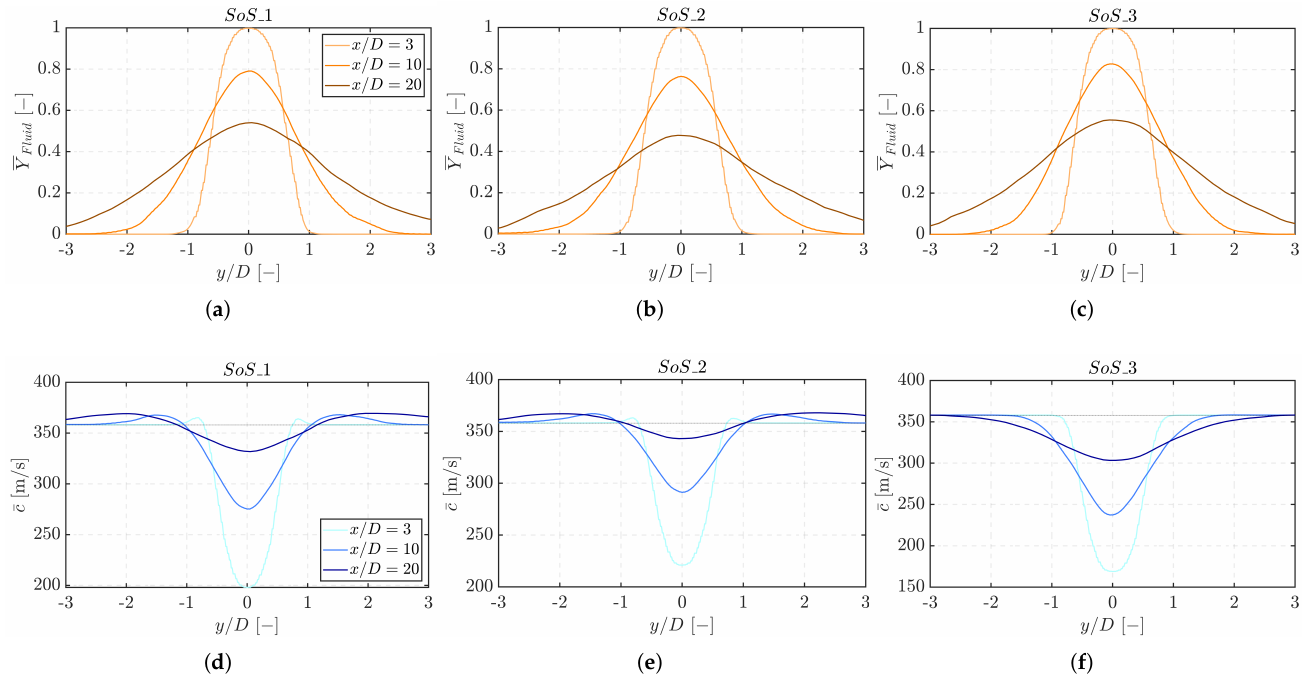
Figure 11. Radial profiles of the mass fraction of the injected fluid ( a – c ) and the mixture speed of sound ( d – f ) at the axial positions x / D = { 3,10,20 } . Data in ( a , d ) correspond to SoS _1, in ( b , e ) to SoS _2 and in ( e , f ) to SoS